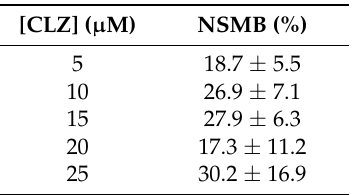
Table 1. NSMB calculated for varying CLZ concentrations. Values displayed as mean ± standard deviation ( n = 4).